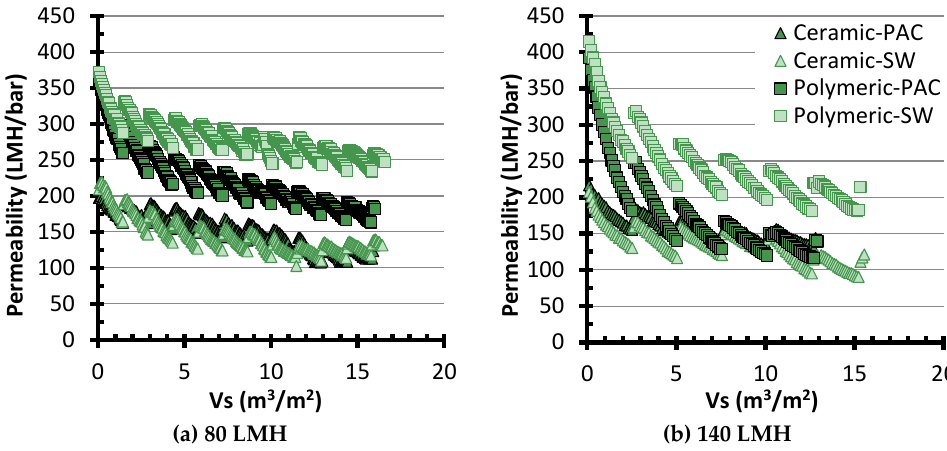
Figure 4. Typical fouling data for assays at ( a ) 80 LMH; and ( b ) 140 LMH. Permeabilities are normalized at 20 °C. SW: Settled Water without PAC pretreatment.